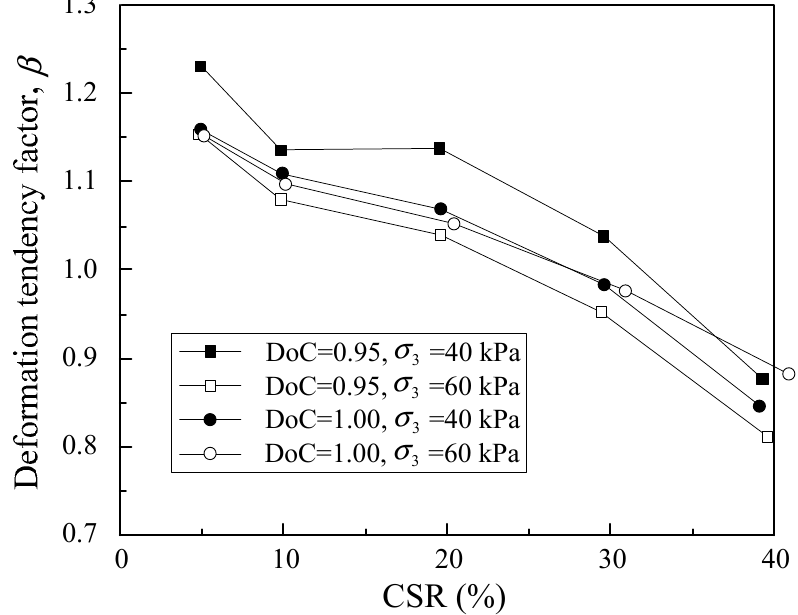
Figure 10. The correlation of deformation tendency factor β with CSR.